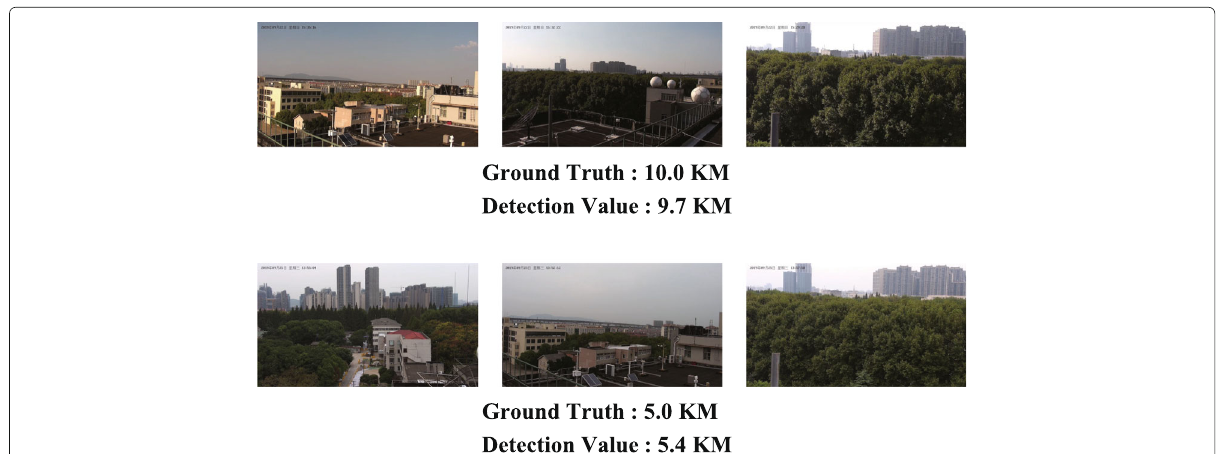
Fig. 9 The estimation results of some images in